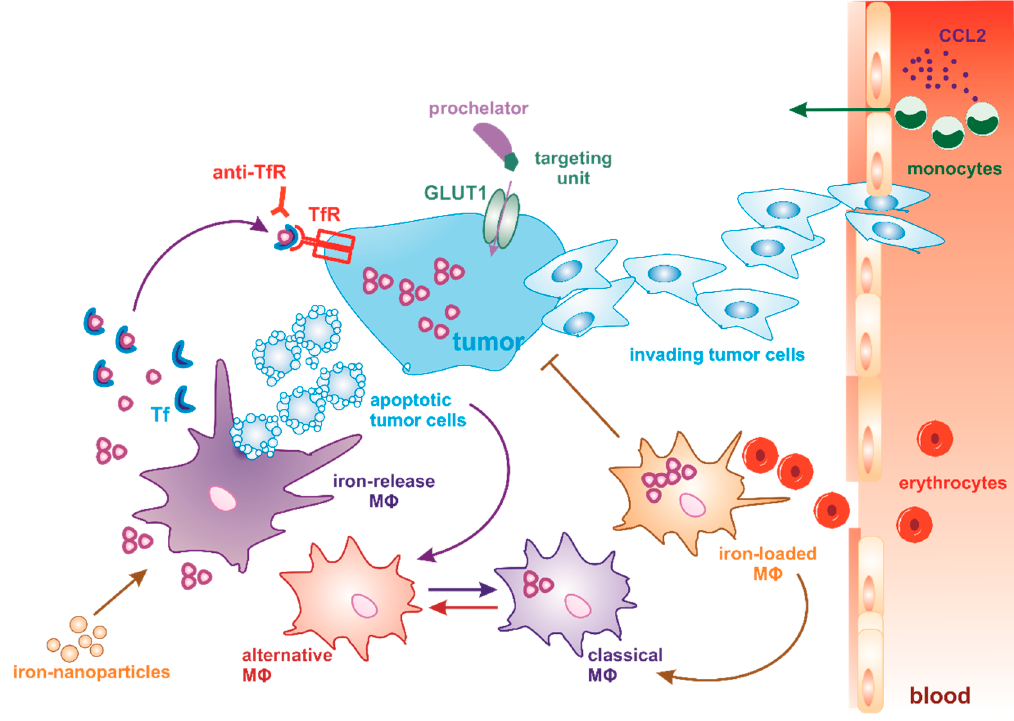
Figure 2. Dynamics and targeting of M Φ phenotypes in the tumor microenvironment. Macrophages (M Φ s) can be targeted to reprogram the immunosuppressive tumor microenvironment and